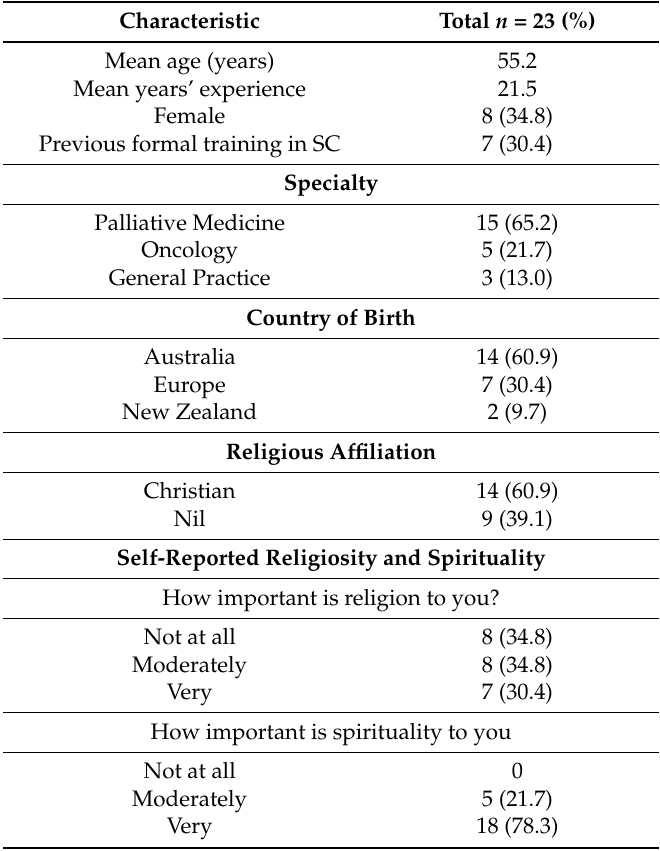
Table 2. Demographic characteristics of